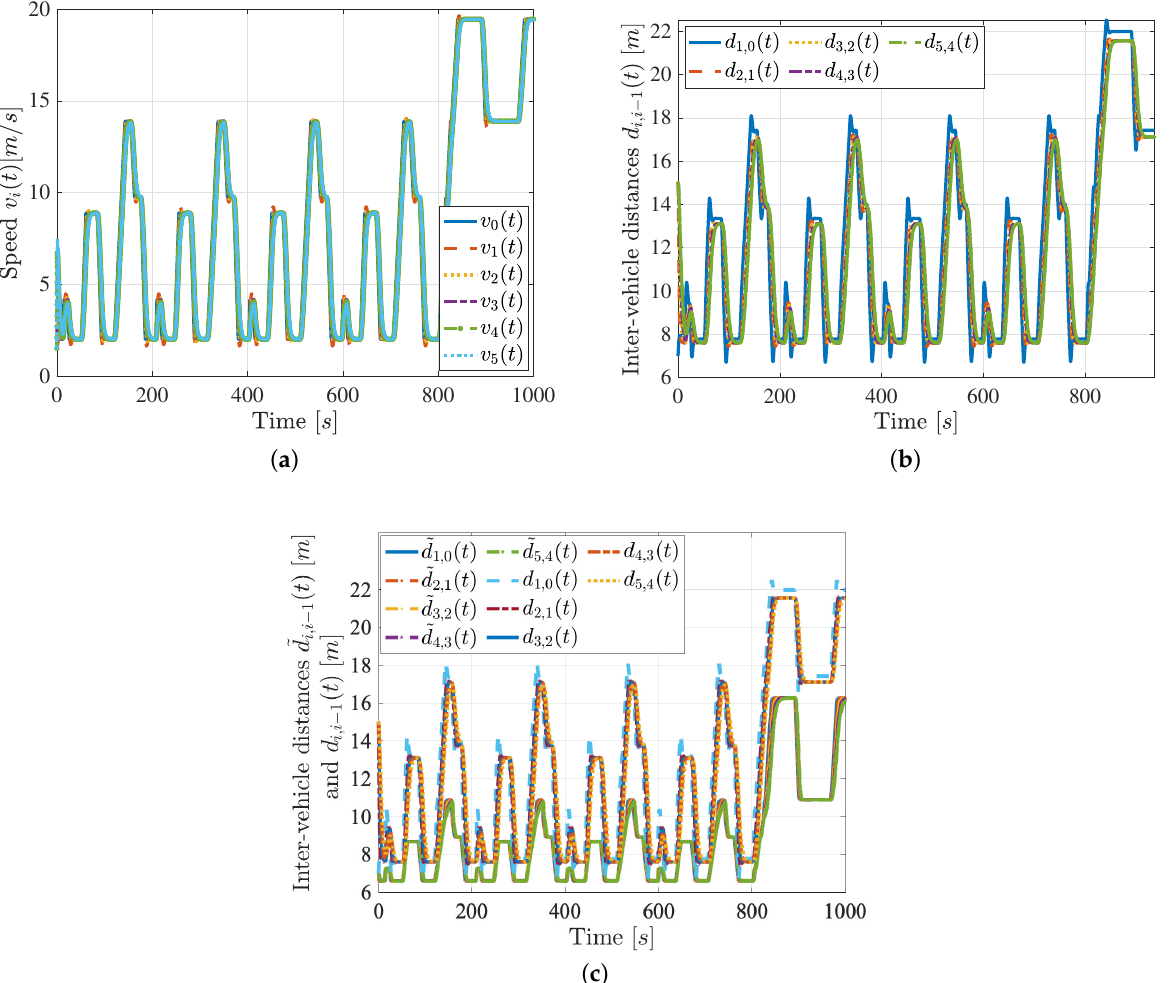
Figure 6. Tracking performances with the more classic distributed diffusive control in (18). Time history of: ( a ) vehicles speed v i ( t ) , i = 0, . . . ,5; i = 0, . . . ,5; ( b ) inter-vehicle distances d i , i − 1 ( t ) , i = 1, . . . ,5; ( c ) comparison between inter-vehicle distances d i , i − 1 ( t ) , i = 1, . . . ,5 and ˜ d i , i − 1 ( t ) , i = 1, . . . ,5 in basic and energy-oriented